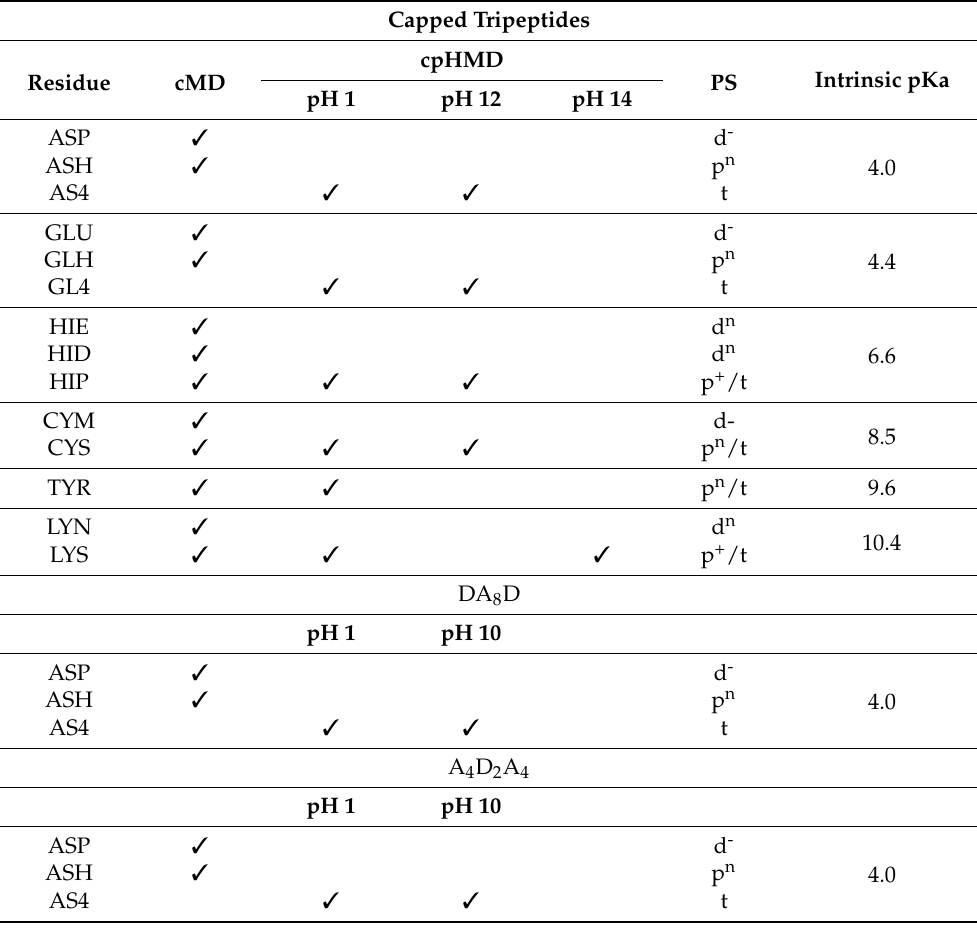
Table 1. Summary of the simulations indicating the peptide, the residue type, the simulation method, the protonation state (PS), and the intrinsic pKa of the amino acids. The PS labels indicate protonated (p), deprotonated (d), or titratable (t) residues while superscripts refer to positive (+), neutral (n), or negative (-) charge of the side chains. The PS of titratable residues depends on the pH conditions (1, 12, or 14) indicated below the cpHMD